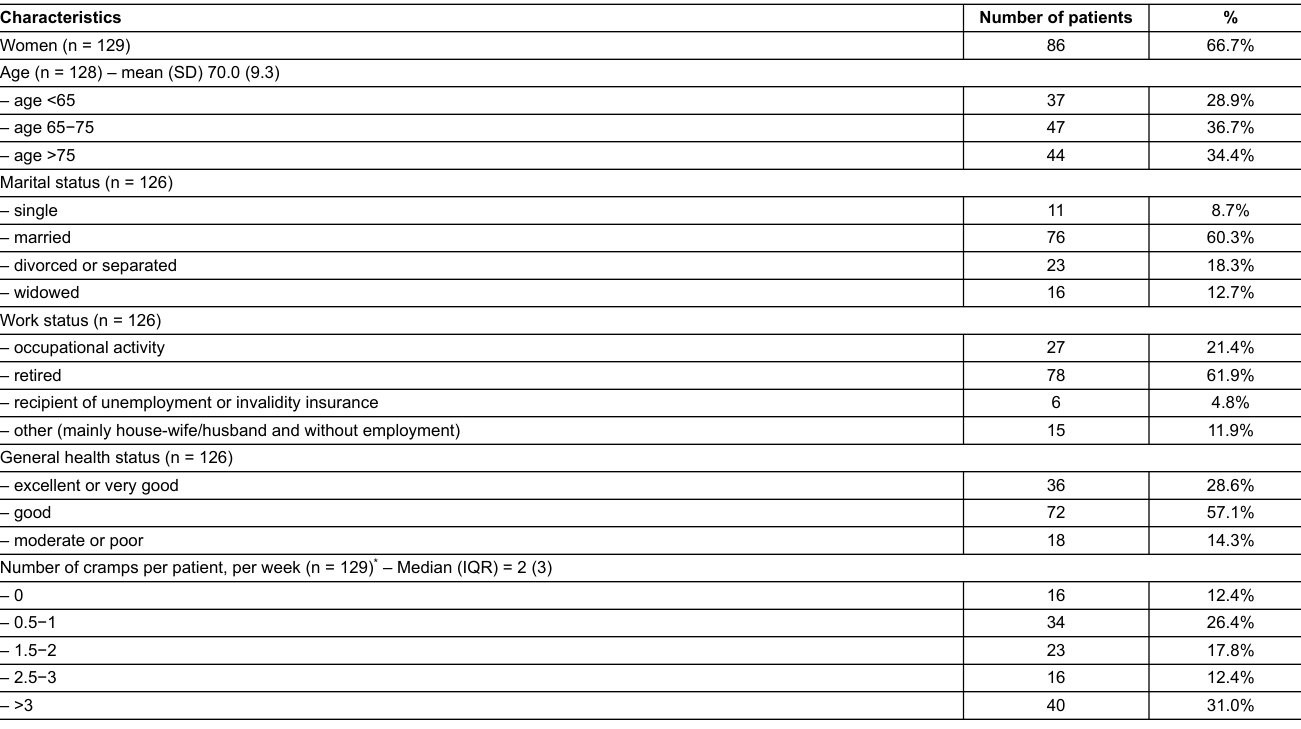
Table 1: Patients’ characteristics (n =